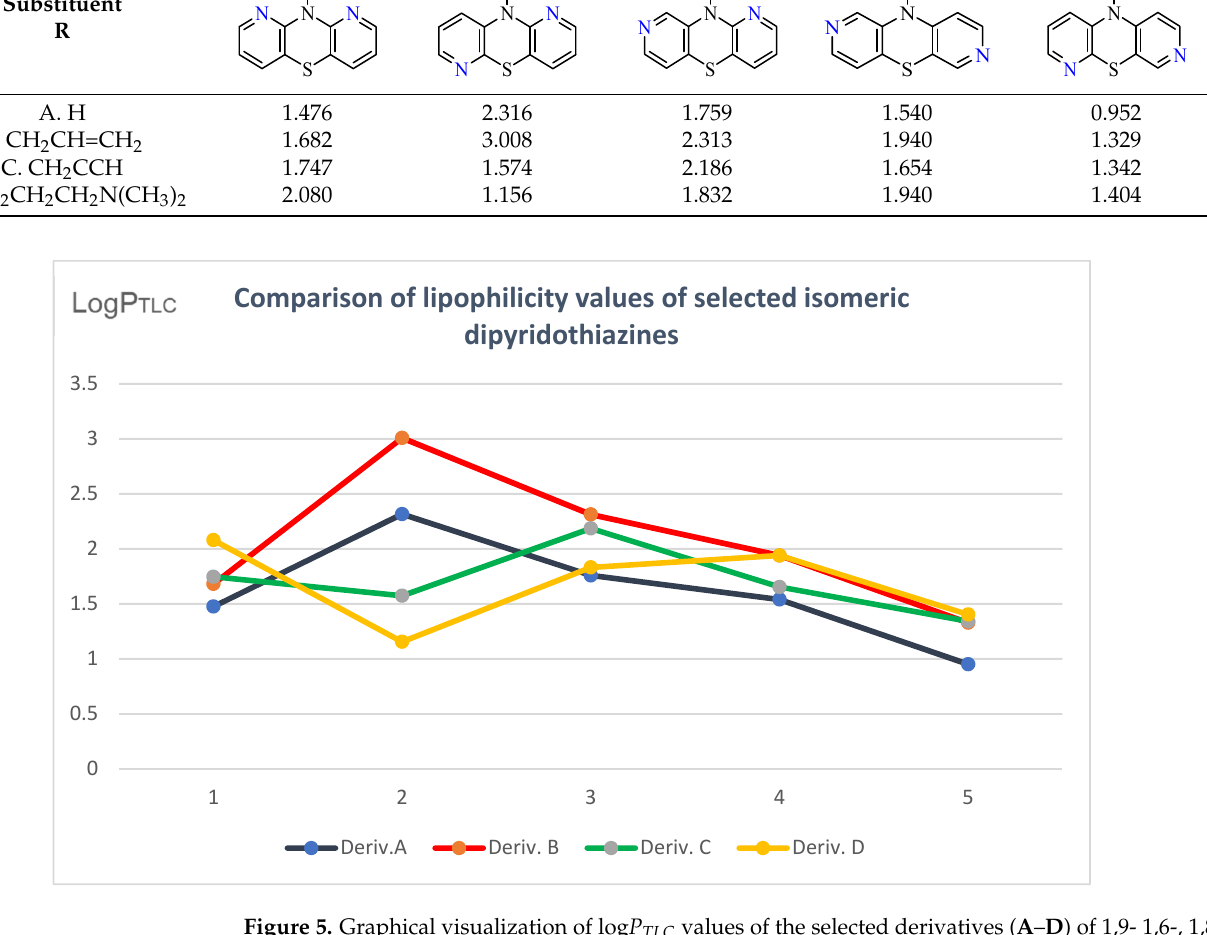
Table 9 . Comparison of the lipophilicity parameter logP TLC of selected isomeric diazaphenothiazines.